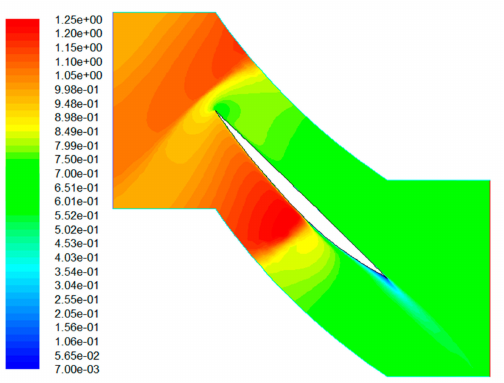
Figure 27. Contours of the Mach number for the second designed blade cascade.